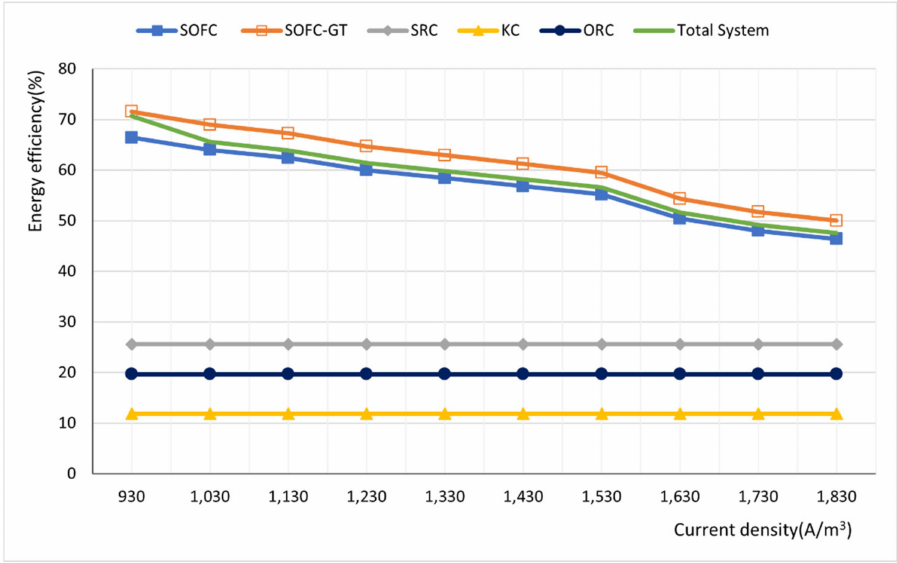
Figure 6. Effect of the current density on the energy efficiency of system.